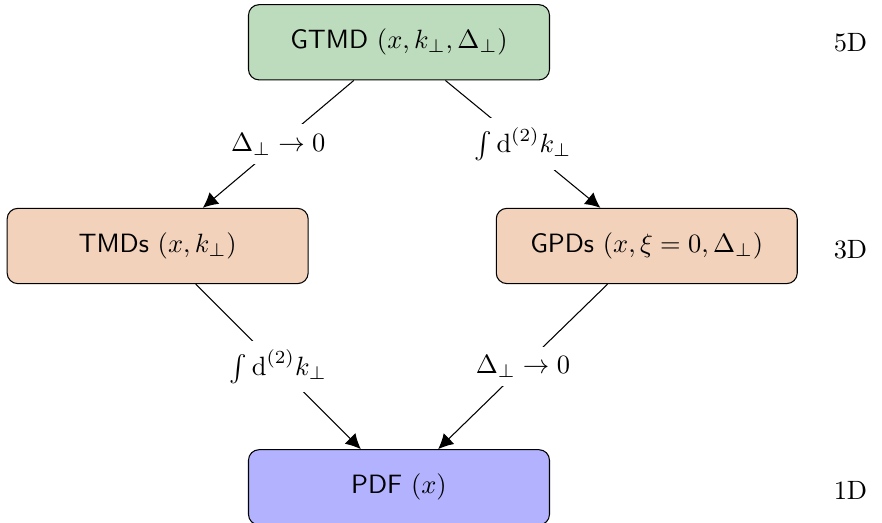
Figure 1. Family of distributions encoding hadron structure, where x is the momentum fraction along the lightcone carried by the active parton, k its transverse momentum (the Fourier conjugate of z ⊥ ∆ is the transverse momentum transferred between the initial and final hadron state. At this stage, ⊥ the integrals over k should be understood as formal only, and need to be regularised, both from ⊥ TMDs to PDFs [8,21,22] and from GTMDs to GPDs [23]. This picture is valid for vanishing skewness ξ , i.e., no momentum transfer along the lightcone is